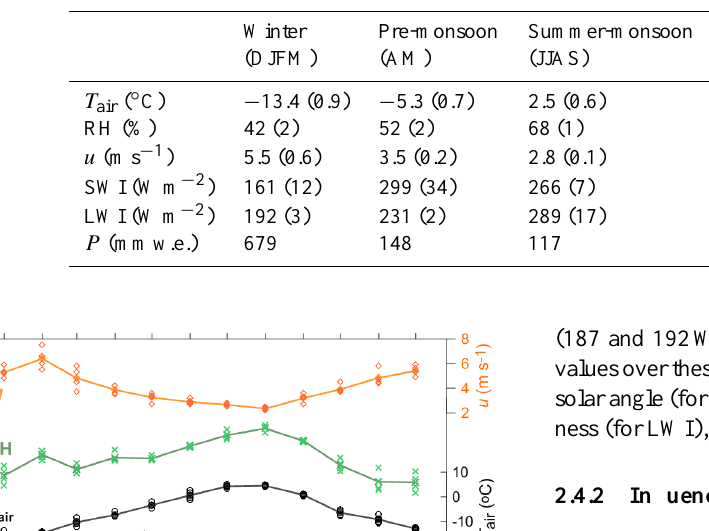
Figure 3. Photographs of AWS1 on Chhota Shigri Glacier taken on 9 October 2012 (left panel) and on 22 August 2013 (right panel) (copyright, Mohd. Farooq Azam). SR50A mounted on a separate pole drilled into the ice, is visible to the left of AWS1. Table 2. Seasonal means and annual mean (standard deviations) of T air , RH, u and SWI over four hydrological years between 1 October 2009 and 30 September 2013 except for LWI (only three years between 1 October 2010 and 30 September 2013) at AWS2 (4863ma.s.l.). P is the seasonal precipitation for one hydrological year between 1 October 2012 and 30 September 2013 at glacier base camp collected by the Geonor T-200B.